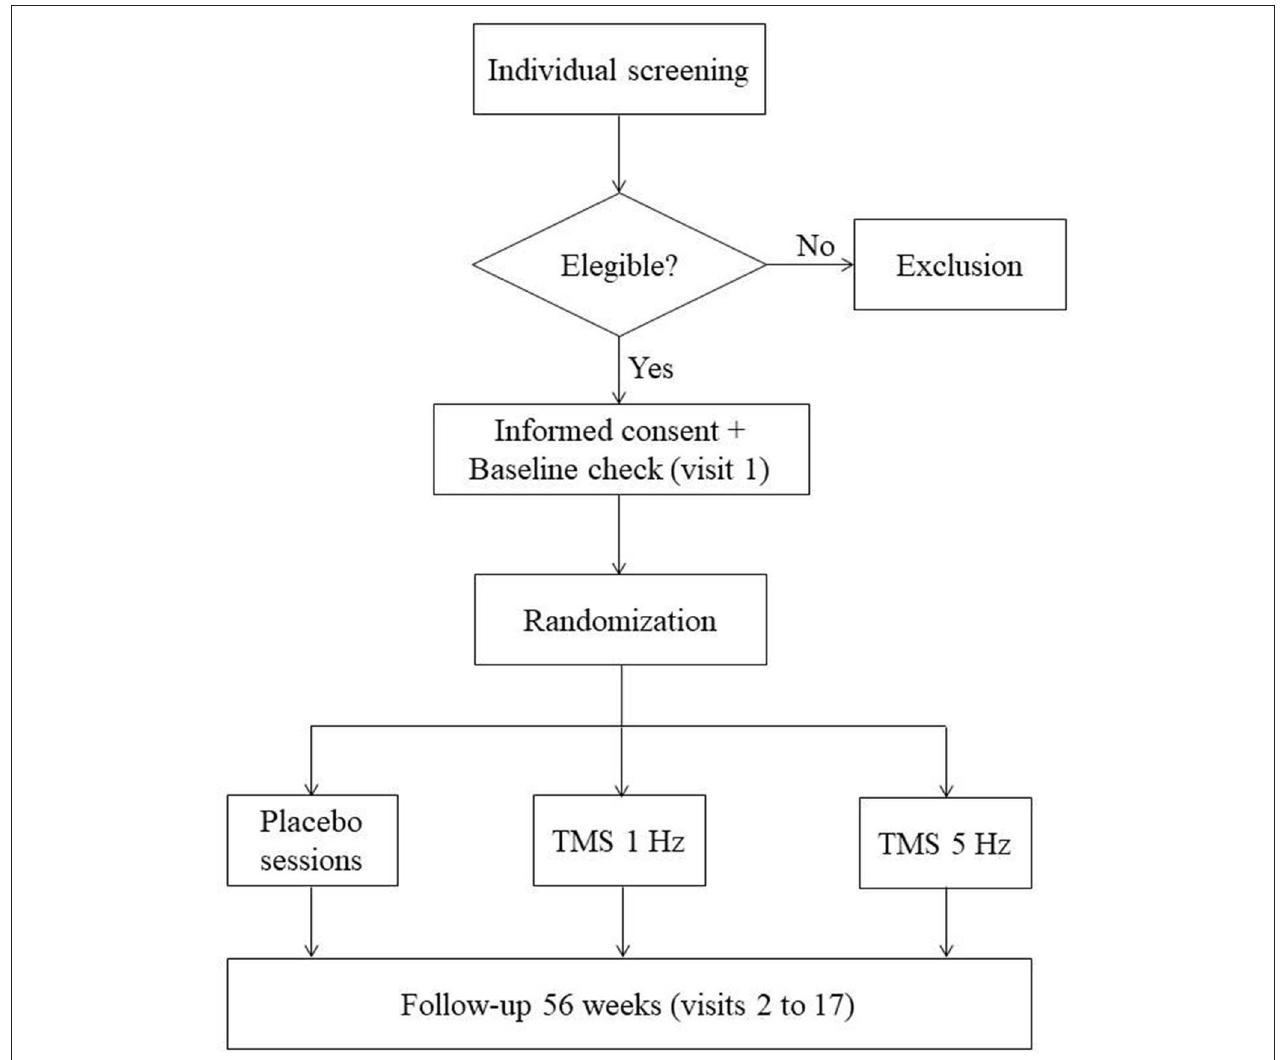
FIGURE 1 | CONSORT flow diagram. Consolidated Standards of Reporting Trials (CONSORT) flow diagram for enrollment and randomization GOAL study.